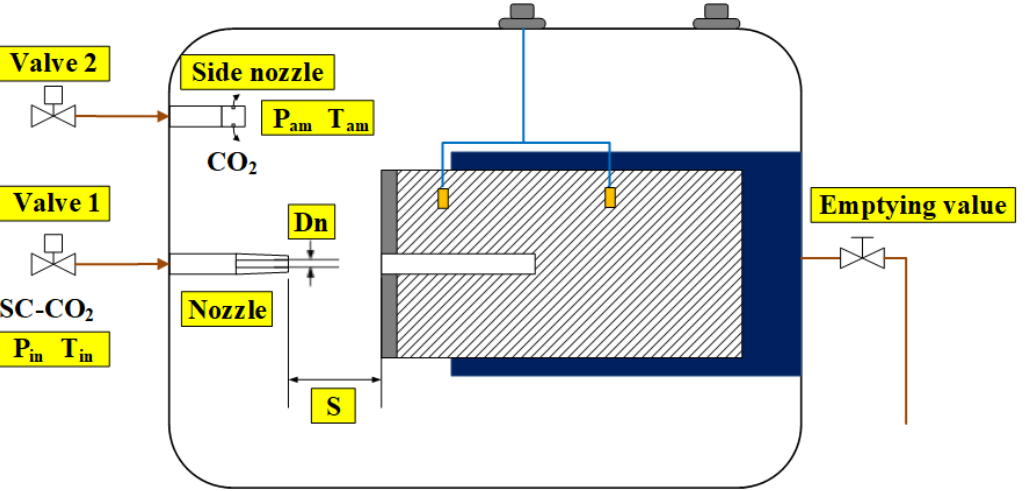
Figure 4. A schematic diagram of the SC-CO 2 jet fracturing kettle.